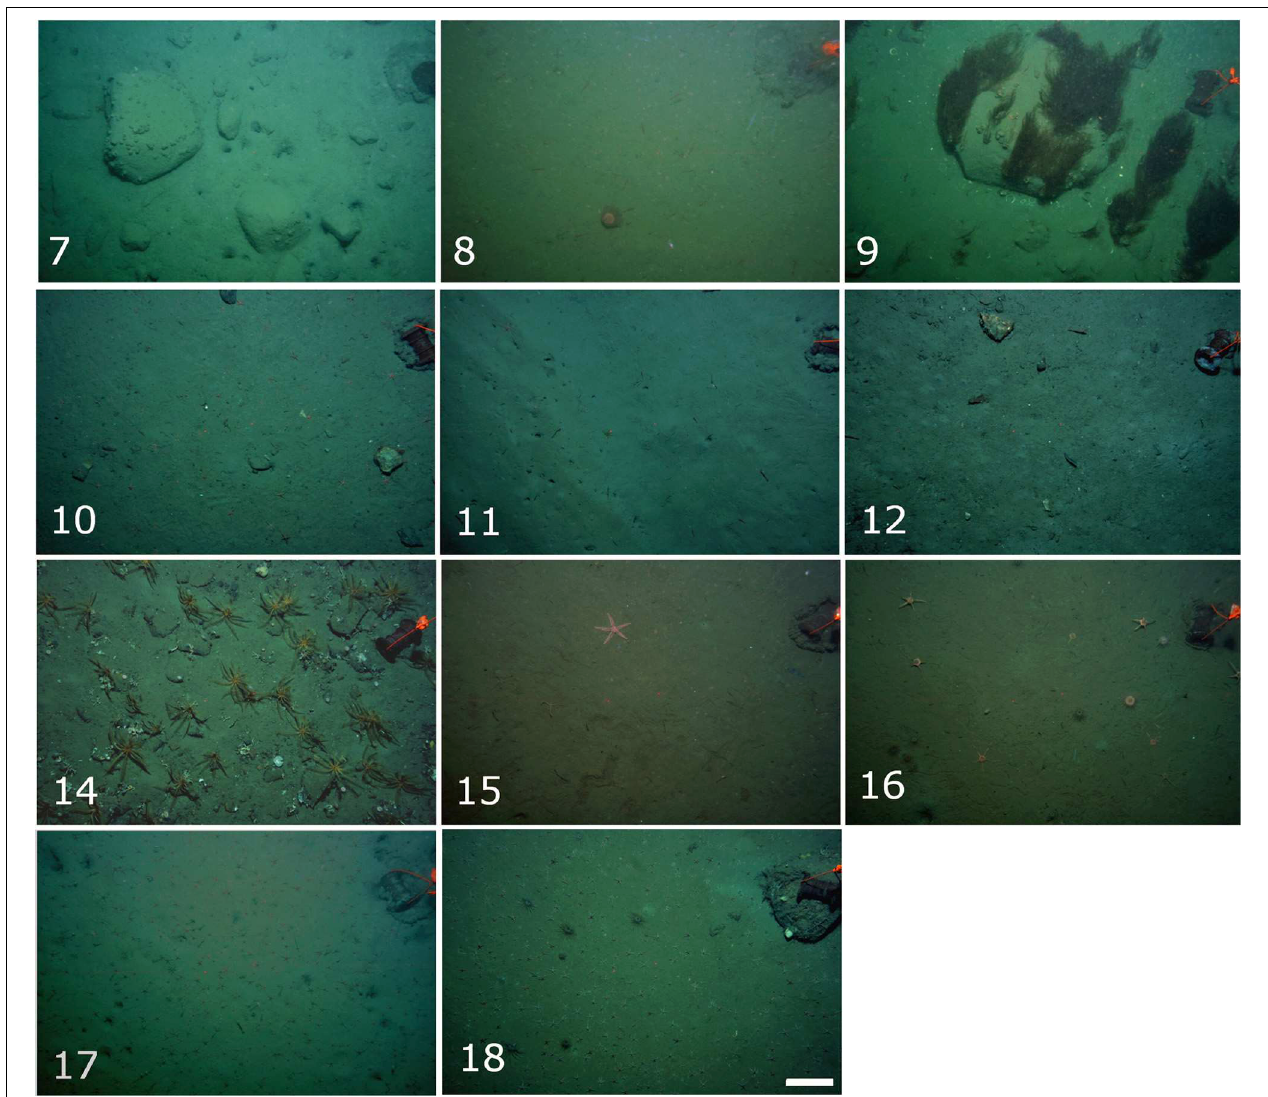
FIGURE 4 | An example photo from each station in north Svalbard. Scale bar =